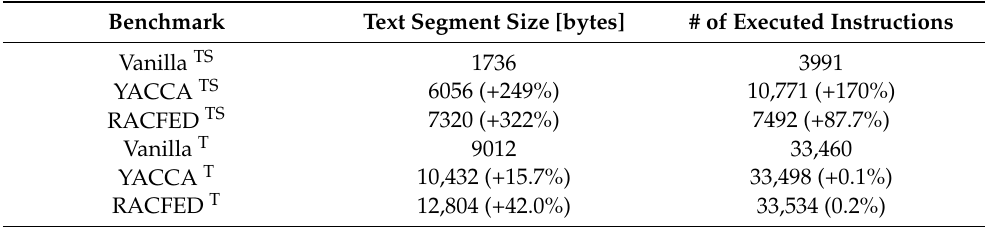
Table 2. Data regarding embedded flash memory occupation and executed instruction. Vanilla refers to the application that is not hardened against control flow errors, and so in its original form.